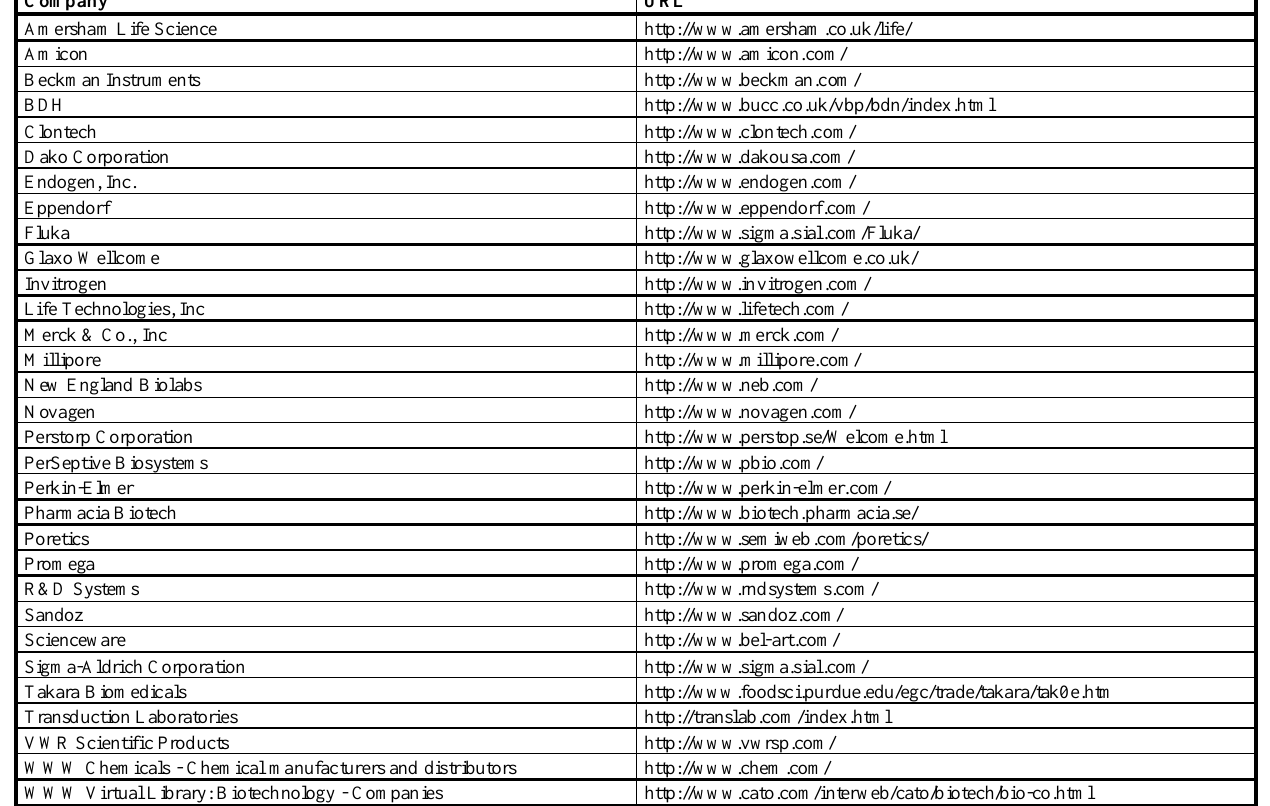
Table 6 - Companies and